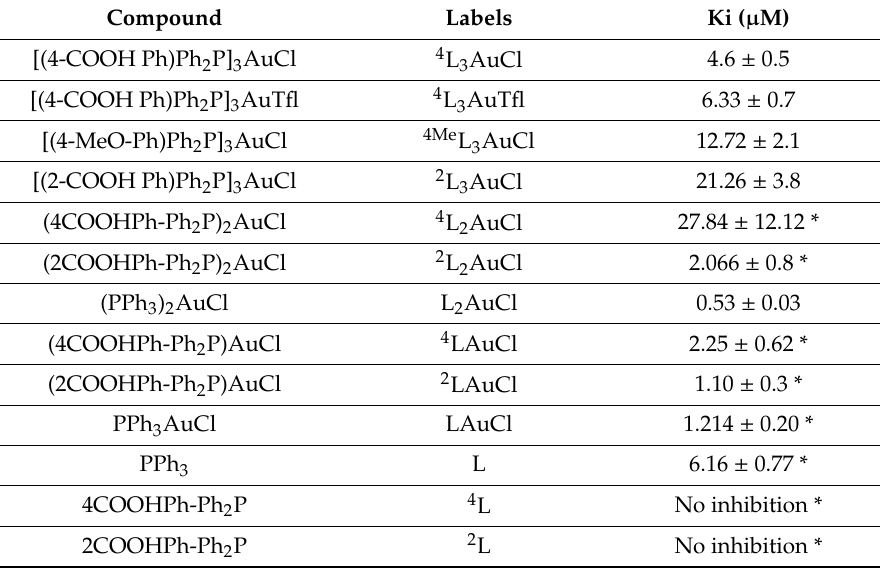
Table 1. List of the compounds tested and corresponding Ki values.